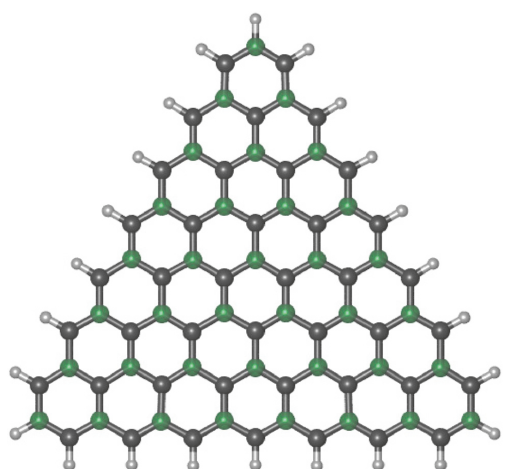
Figure 1: H 6 geometry: sublattice A in green; sublattice B in grey.